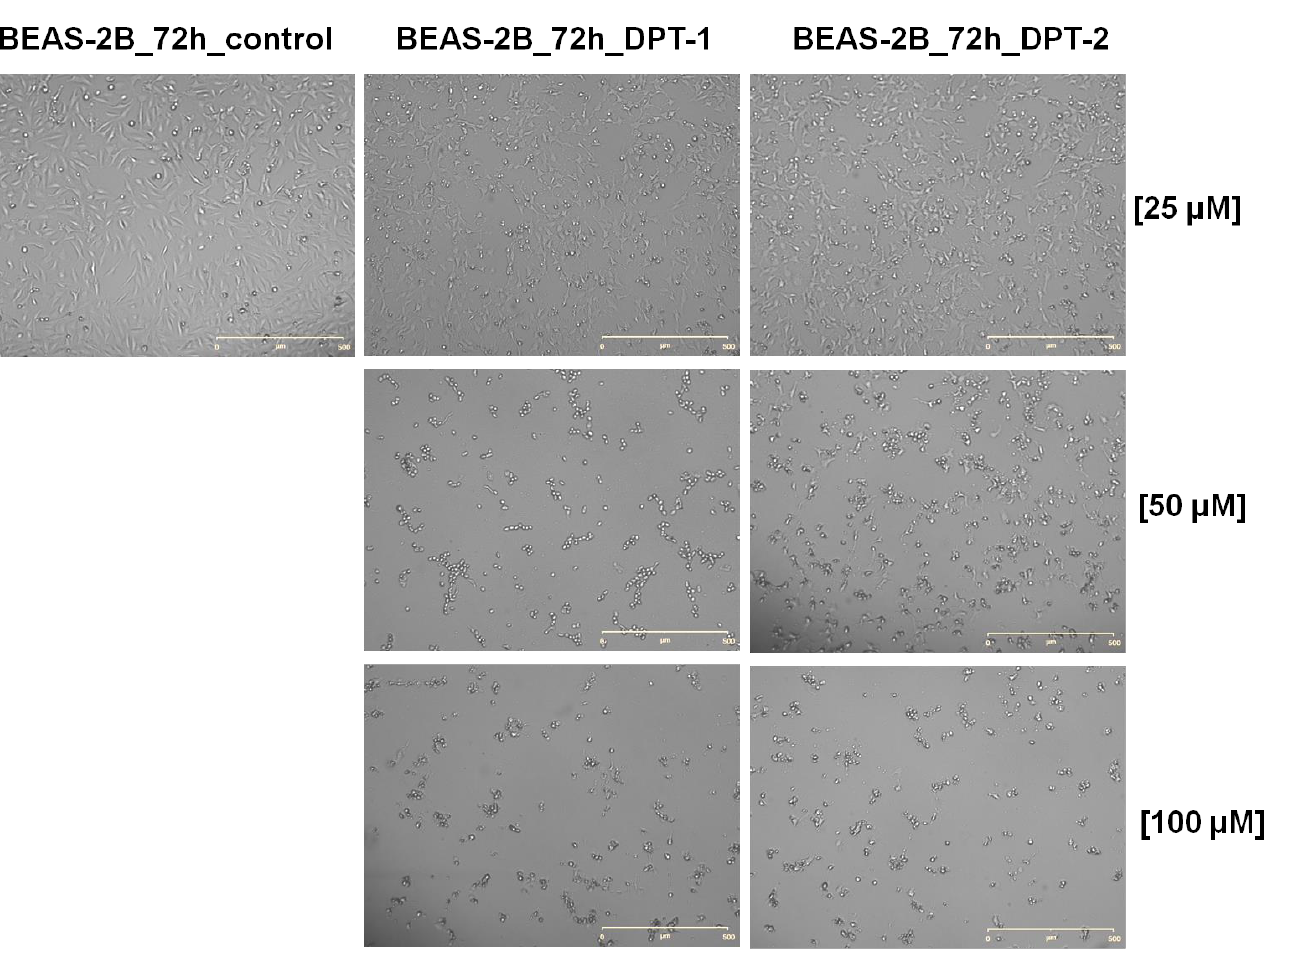
Figure 9. Dose-dependent cellular death in control and DPT-1 - and DPT-2 -treated BEAS-2B cells treated for 72 h, followed by Live Cell Analyzer images acquisitions. Magnification 100×; scale bar 500 µM.